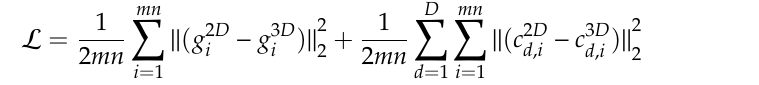
( h ) Figure 3. ( a ) and ( c ): RGB gait images from CASIA B gait dataset ( e ) and ( g ): rendered RGB gait images of synthesized 3D gait model with virtual dressing, and ( b ), ( d ), ( f ), and ( h ): the corresponding semantically parsed images. Since the imaged body shape can be greatly influenced by the clothes worn, it is important to obtain clothes information before morphing the 3D parametric body model, according to Equation (2). Unlike a 2D gait approach, there are several approaches to deal with clothes, e.g., using virtual clothing and virtual garment stitching. The 3D parametric gait semantic data extraction process